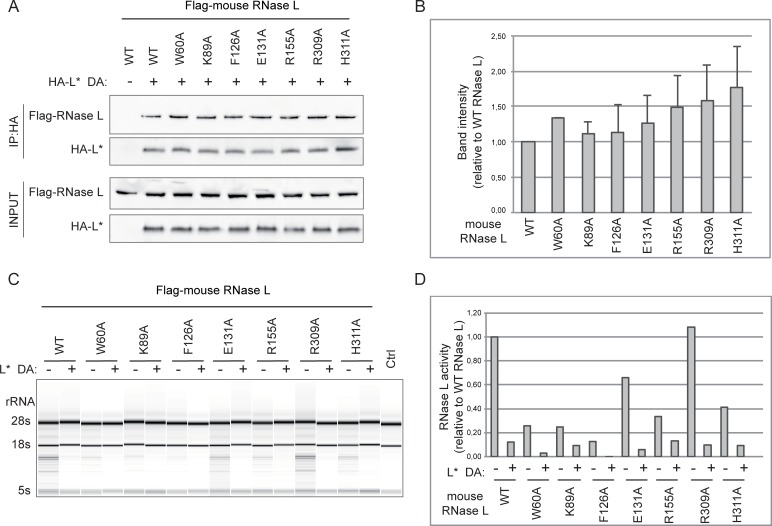
RNase L residues involved in 2-5A binding are not crucial for L* binding to mouse RNase L.A-B. Co-immunoprecipitation of indicated 2-5A binding-defective mouse RNase L mutants with HA-tagged L*DA. A. Immunoblots show Flag (RNase L) and HA (L*) detection after immunoprecipitation of HA (upper panels) and in cell lysates (Input, lower panels). B. Graphs showing the quantification of coimmunoprecipitated RNase L mutants relative to coimmunoprecipitated WT mouse RNase L (n = 3). Differences were non-significant according to one-way ANOVA followed by Tukey's test for multiple comparisons. C-D. Analysis of RNase L-mediated RNA degradation in HeLa-M cells overexpressing indicated Flag-RNase L and HA-L*DA. RNA samples extracted 7 hours after polyI:C transfection were analyzed by RNA chips (C) and quantified (D). Graphs show the quantification of RNA degradation by RNase L mutants in the absence or in the presence of L*DA. Data are normalized to those of WT RNase L in the absence of L*.